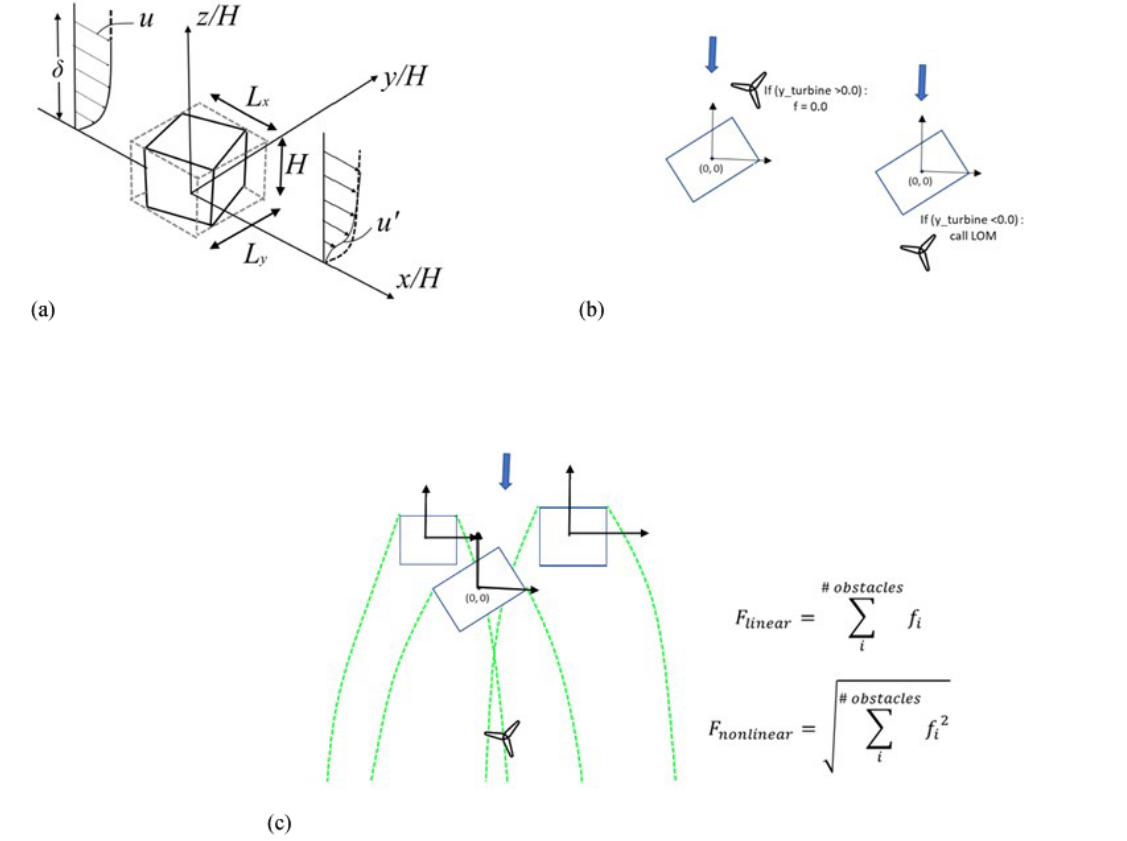
Figure 5. Schematic describing ANL and ANL–ML